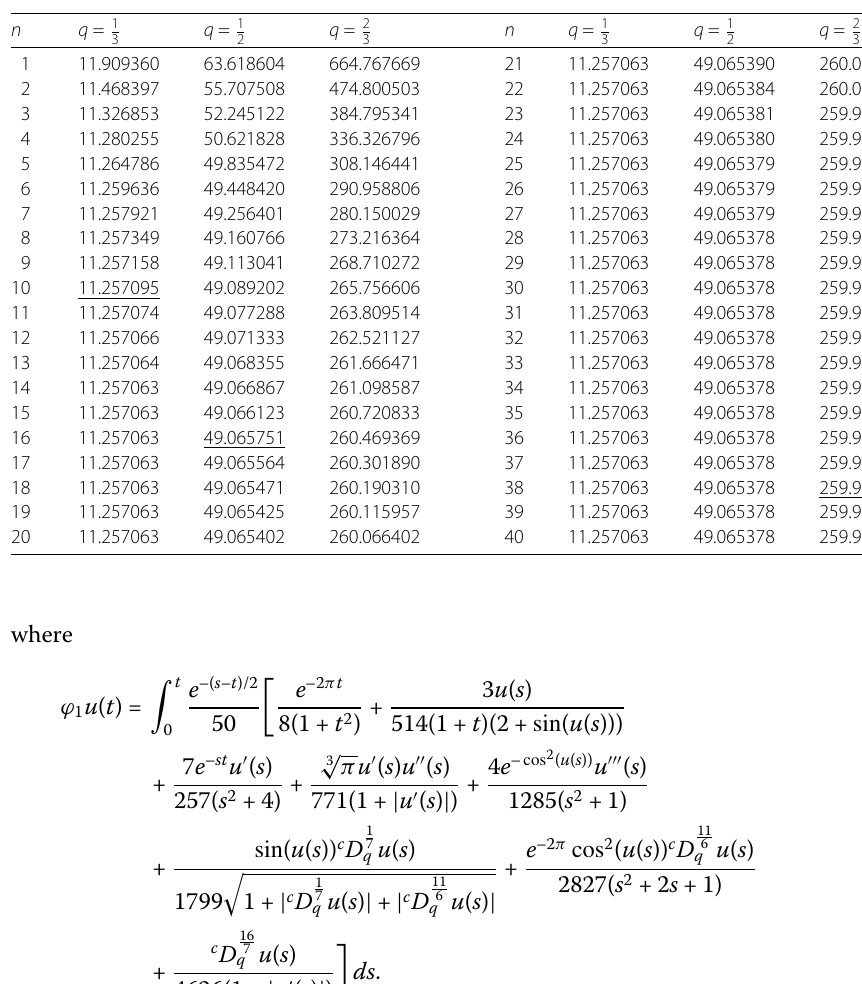
, 1 , 2 and n = 1,2, ... ,40 3 2 3